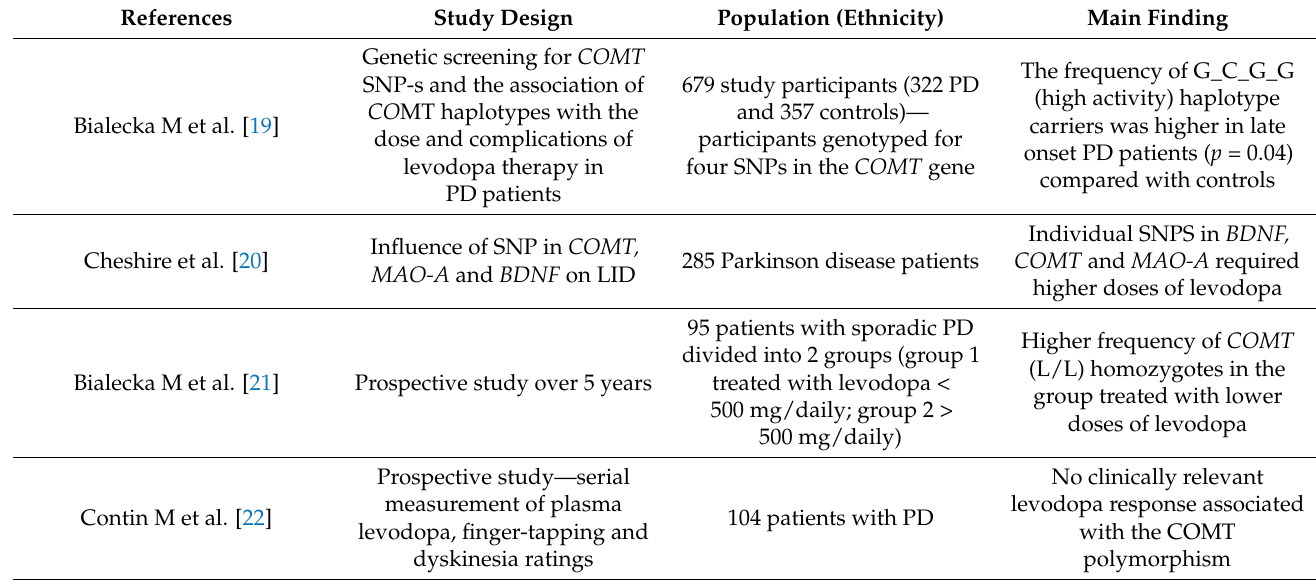
Table 1. Pharmacogenomic studies cited in the systematic